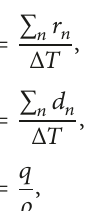
change in speed over space. The former three variables are determined using [16] generalized